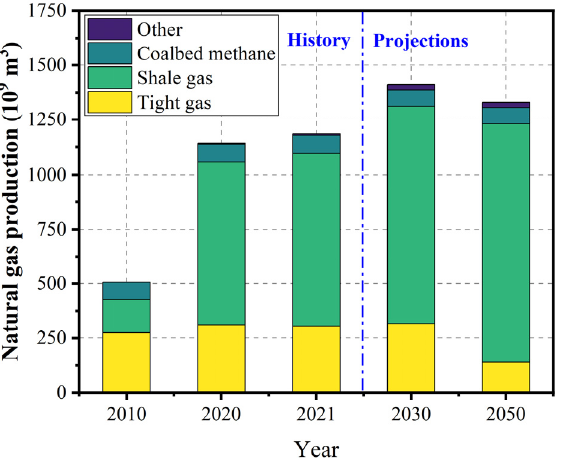
Figure 1. World unconventional natural gas production and forecast [3].